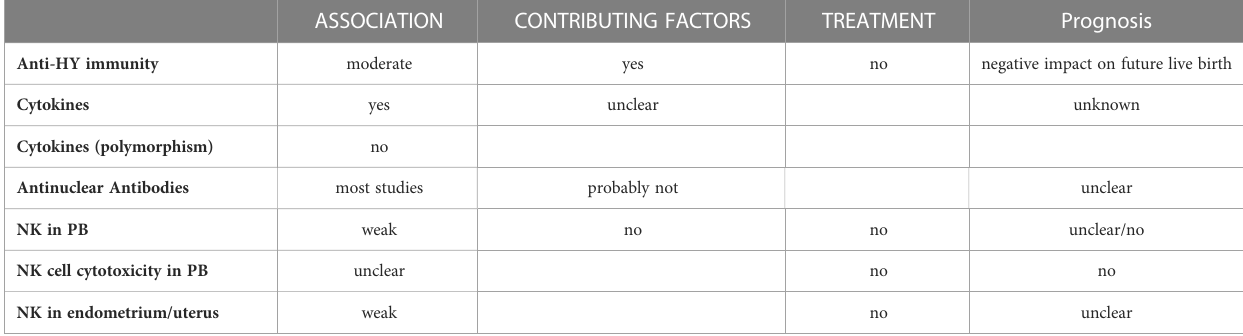
TABLE 1 ESHRE Guidelines on immunological biomarkers.